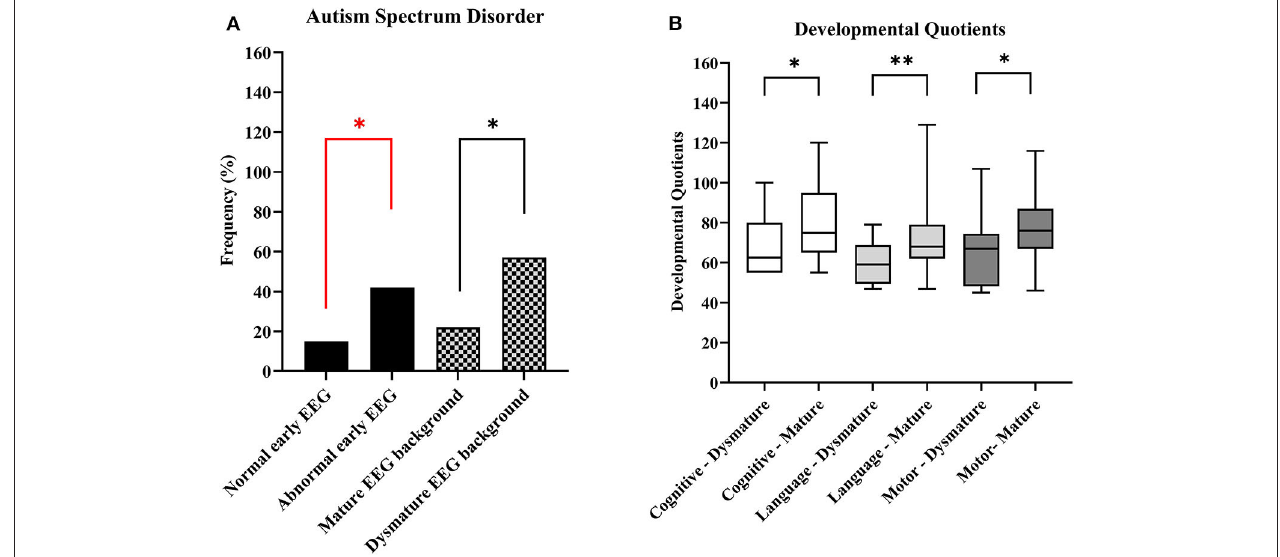
FIGURE 1 | Overview of EEG characteristics and neurodevelopmental outcome at the age of 24 months. (A) Autism spectrum disorder by EEG abnormalities. (B) Cognitive, language and motor developmental quotients based on Bayley Scales of Infant and Toddler Development -III test results. * p -value < 0.05, ** p -value < 0.01. A red line indicates significance in a multivariable